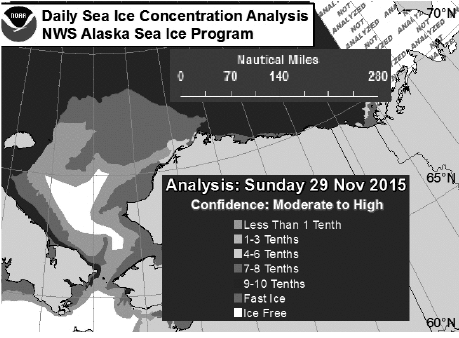
Fig. 5. Regional map in polar stereographic projec- tion No. 15 in GIF format issued by the NWS /